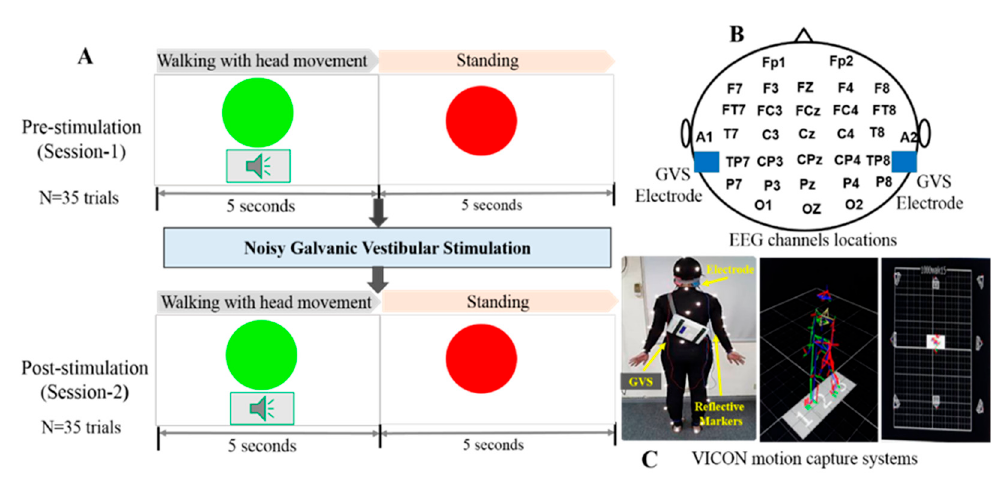
Figure 1. Experimental design. ( A ) Presentation of green and red circle stimuli for walking and standing in pre-stimulation and post-stimulation conditions. ( B ) Placement of electroencephalography (EEG) electrodes. EEG cap with 32 channels was placed on the scalp according to the International 10–20 System. Galvanic vestibular stimulation (GVS) electrodes were placed with one electrode on the mastoid process behind each ear denoted by blue square. ( C ) VICON motion capture (Vicon Motion Systems Ltd., Oxford, UK) process: Subjects wore standard motion capture suits with plug-in-gait model setting. (Left and middle figures). The wireless transcranial direct-current stimulation (tDCS) box was fixed on the subjects’ backs. The subjects were tested in the capture volume with eight cameras (right figure).